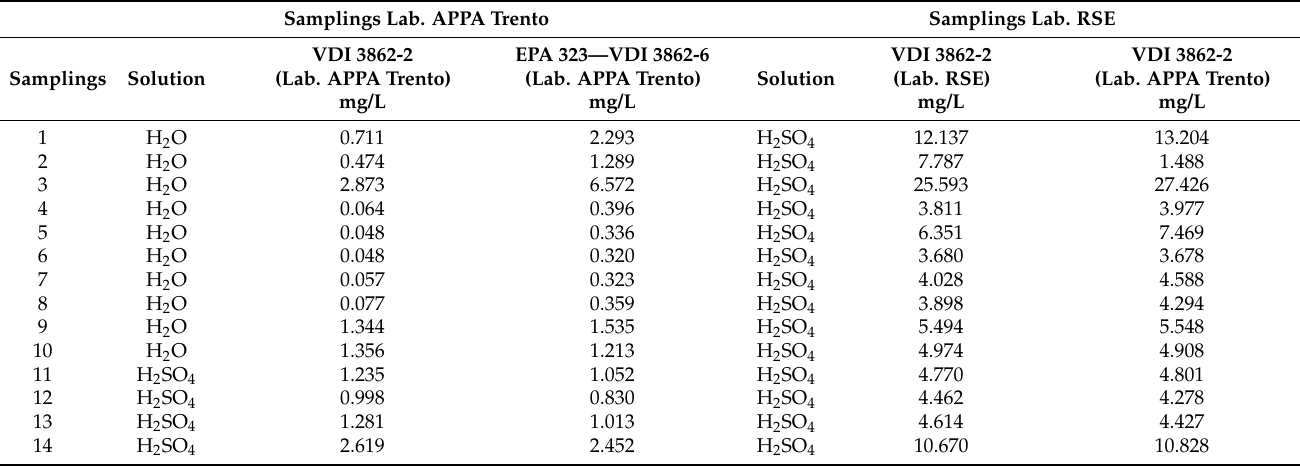
Table 9. Concentration of H − CHO analyzed during the First Campaign.